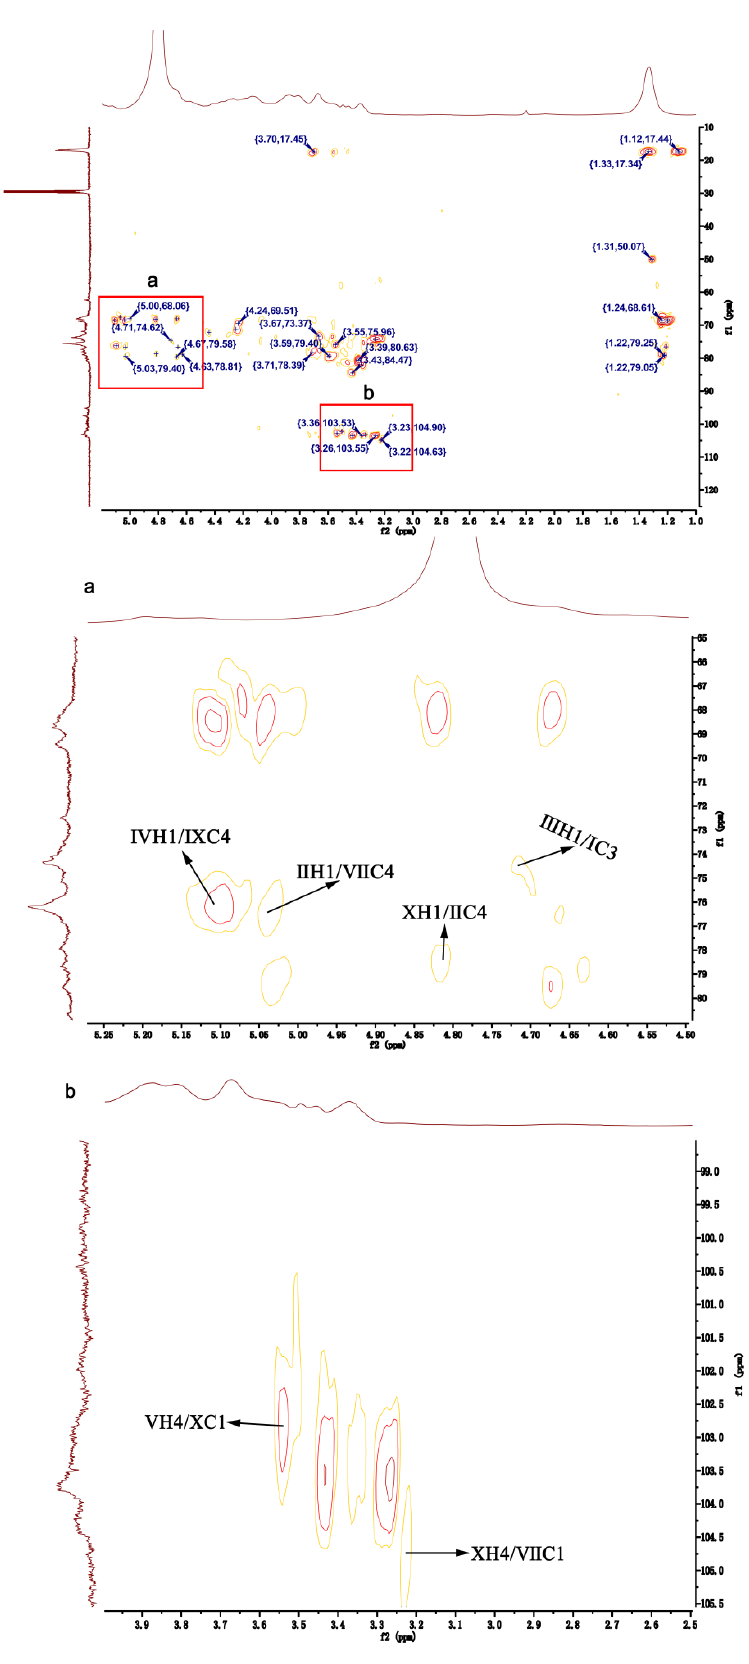
Figure 5. HMBC NMR of HU.